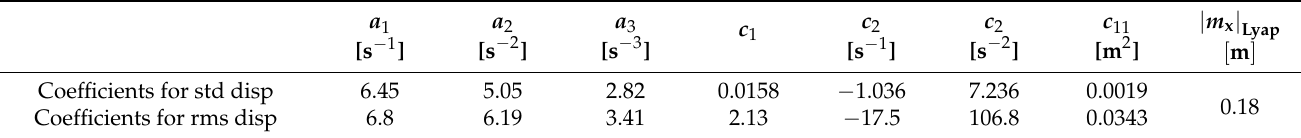
Table 8. Coefficients of attached linear system for std and rms